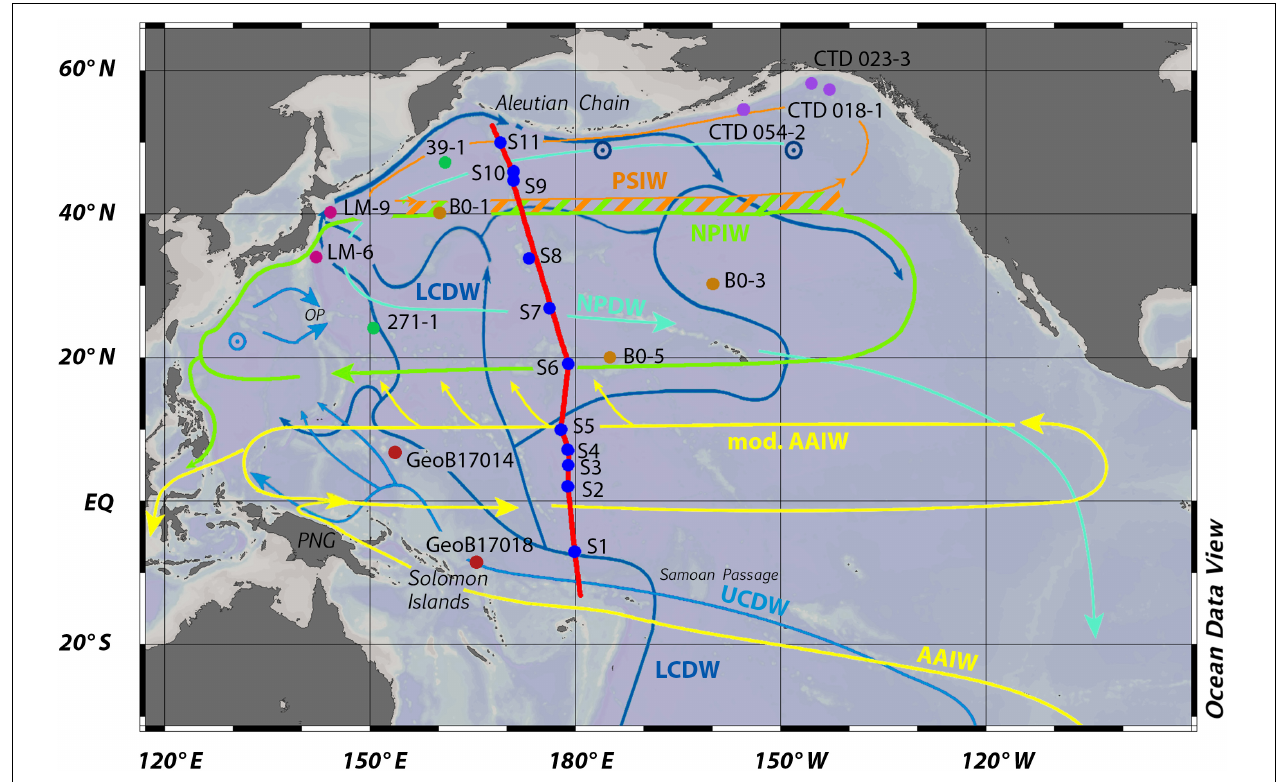
FIGURE 1 | Schematic circulation of intermediate and deep-water masses in the Equatorial and North Pacific (Schmitz, 1996; Kawabe and Fujio, 2010; Tomczak and Godfrey, 2013b; Behrens et al., 2018). The SO264 longitudinal transect (red bold line) and sampling locations (blue dots) of this study are shown along with those selected from Piepgras and Jacobsen (1988) (green dots), Amakawa et al. (2004b) (pink dots), Amakawa et al. (2009) (brown dots), Haley et al. (2014) (purple dots), and Behrens et al. (2018) (red dots). The hatched (green/orange) area depicts mixing of NPIW and PSIW (this study). The light blue circle with a center point marks the approximate location of upwelling of UCDW into the intermediate layer. The dark blue circles with center points mark upwelling of LCDW and its transformation into NPDW (Kawabe and Fujio, 2010). OP, Ogasawara Plateau; PNG, Papua-New-Guinea. Abbreviations used for water masses and currents are listed in Table 1 . The map was created using Ocean Data View (Schlitzer, 2020) and further modified.